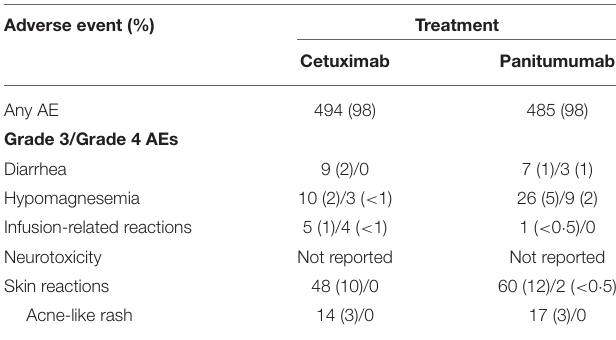
TABLE 4B | Evidence from the phase 3, head-to-head ASPECCT trial in 3L KRAS wt mCRC patients (101). Adverse event